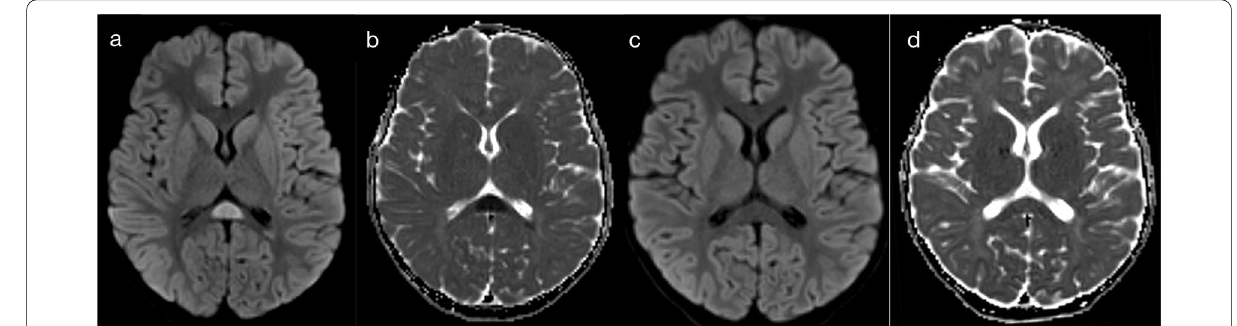
Fig. 9 Restricted diffusion in corpus callosum (Pattern 3). 3‑year‑old child with gastrointestinal illness, followed by lethargy, irritability and suspected focal seizures. Stool was positive for norovirus. DWI ( a ) and ADC map ( b ) demonstrated a cytotoxic lesion midline within the splenium. Follow‑up MRI 2 weeks later demonstrated complete resolution of the splenial lesion on DWI ( c ) and ADC ( d )